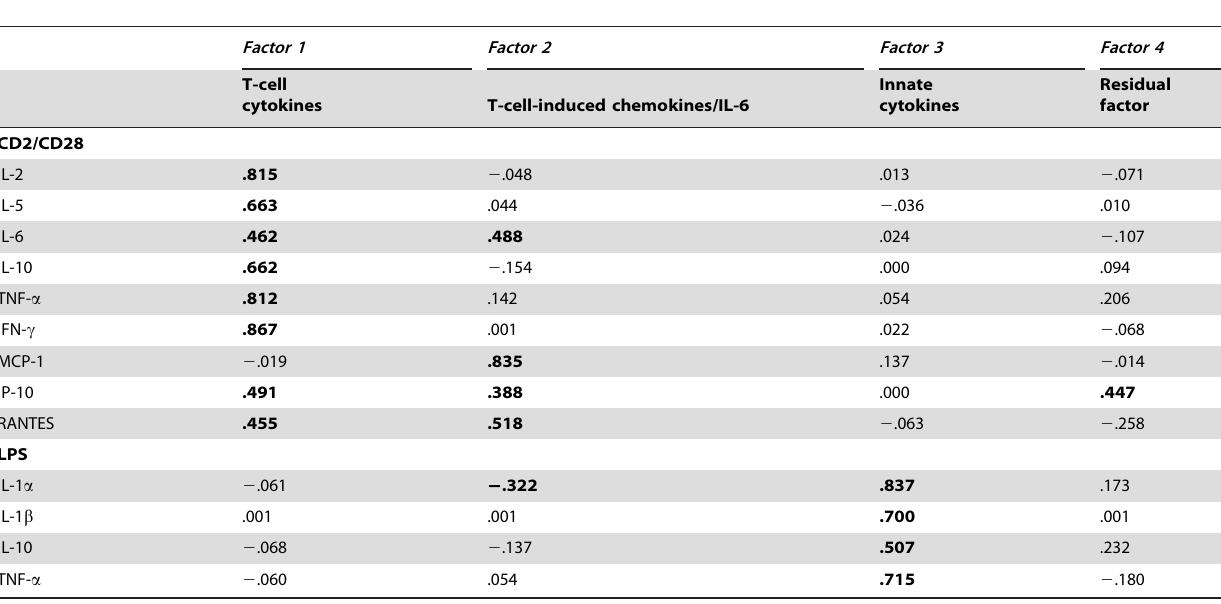
Table 3. Final exploratory structural equation _odelling (ESEM) factor